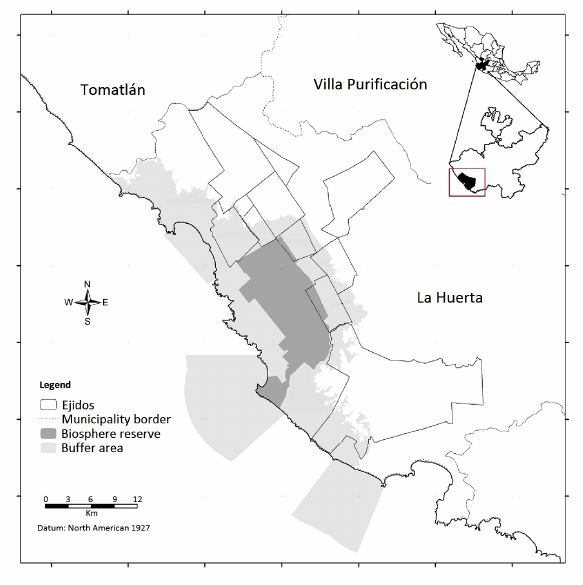
Fig. 1 . Study site location. Ejidos are areas with semicommunal land ownership that surround the Chamela-Cuixmala Biosphere Reserve